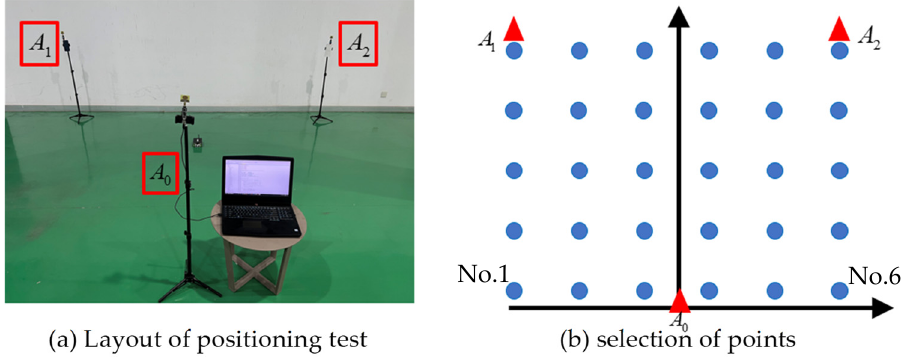
Figure 15. Positioning test layout.